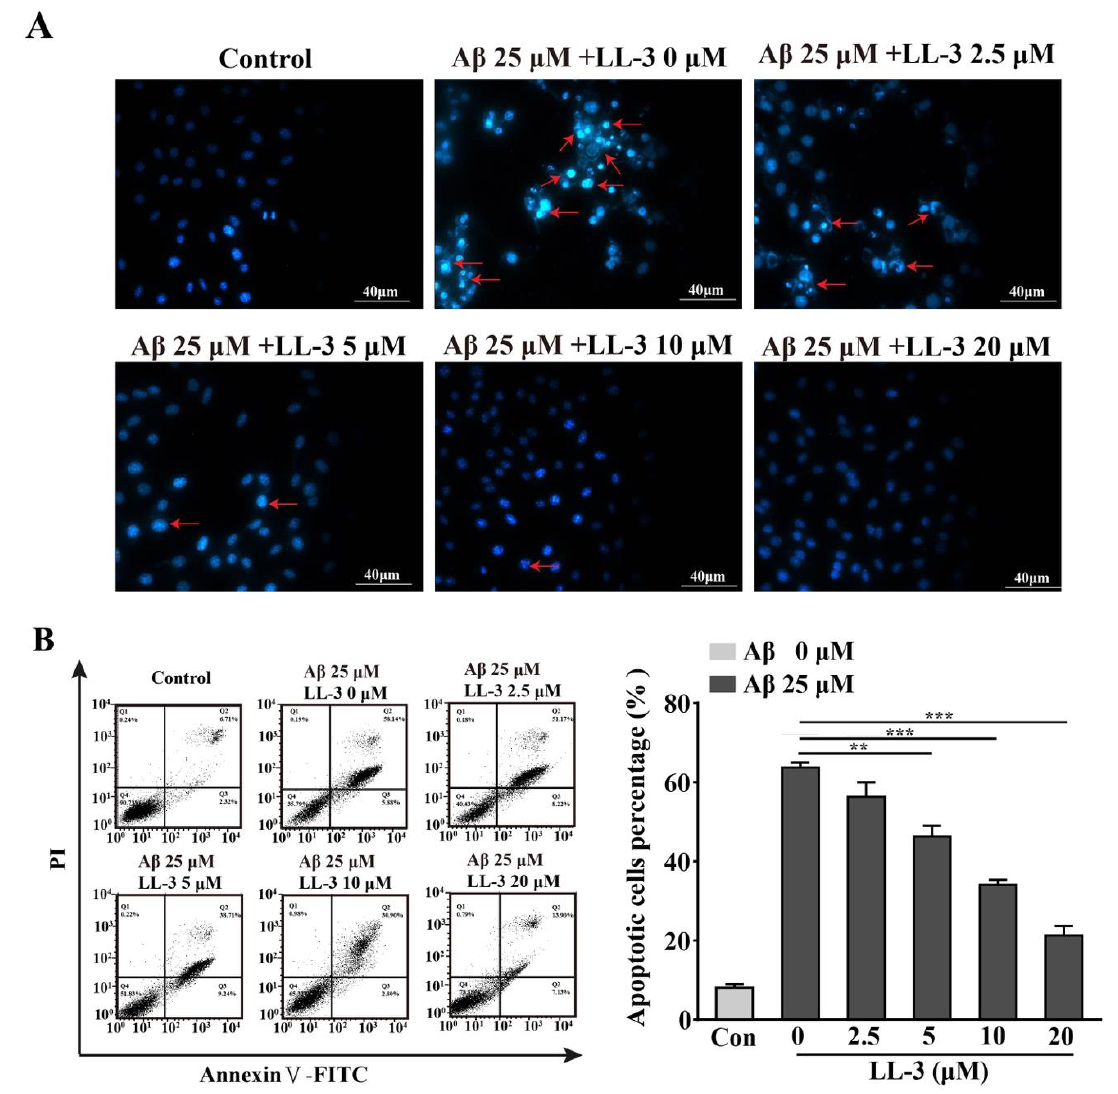
Figure 5. LL-3 inhibited A β 25-35 -caused apoptosis. LL-3 was pretreated prior to A β 25-35 for 30 min. After 48 h, cells were detected using diamidino-2-phenylindole (DAPI) staining and viewed under Cytation 5 Imaging Reader. ( A ) Arrows indicated the apoptotic nuclei. ( B ) Quantification of abnormal nuclei after exposure to A β 25–35 in the presence or absence of LL-3. The results are representative of three independent experiments. Data were mean ± SD, ** p < 0.01, and *** p < 0.001 compared to A β 25-35 alone.